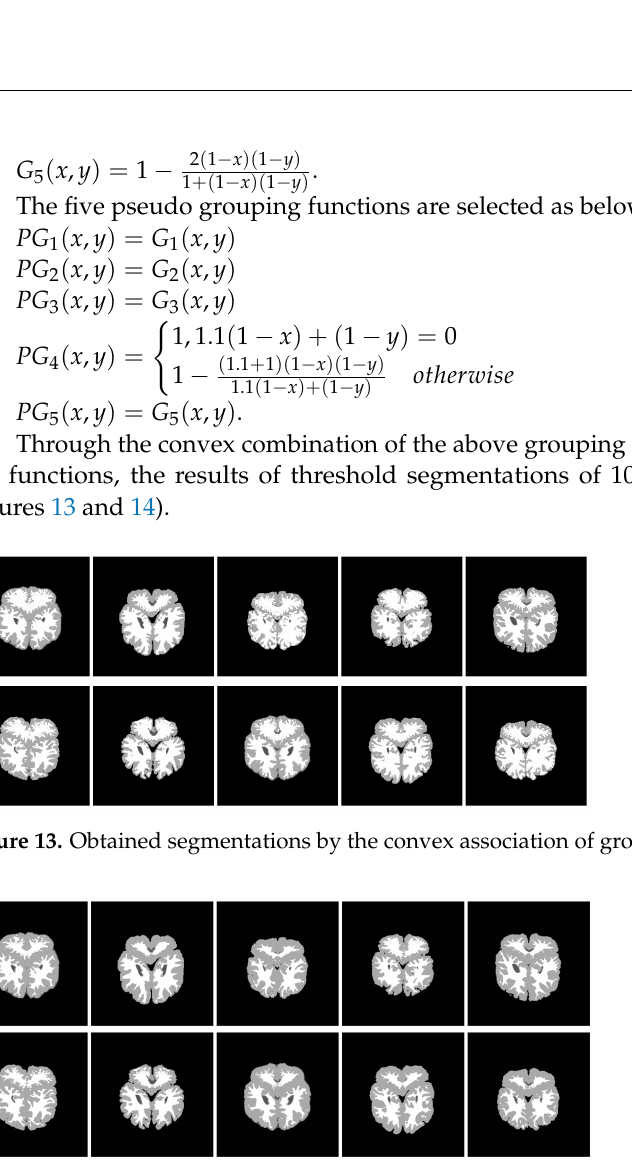
Figure 14. Obtained segmentations from the convex association of pseudo grouping functions.